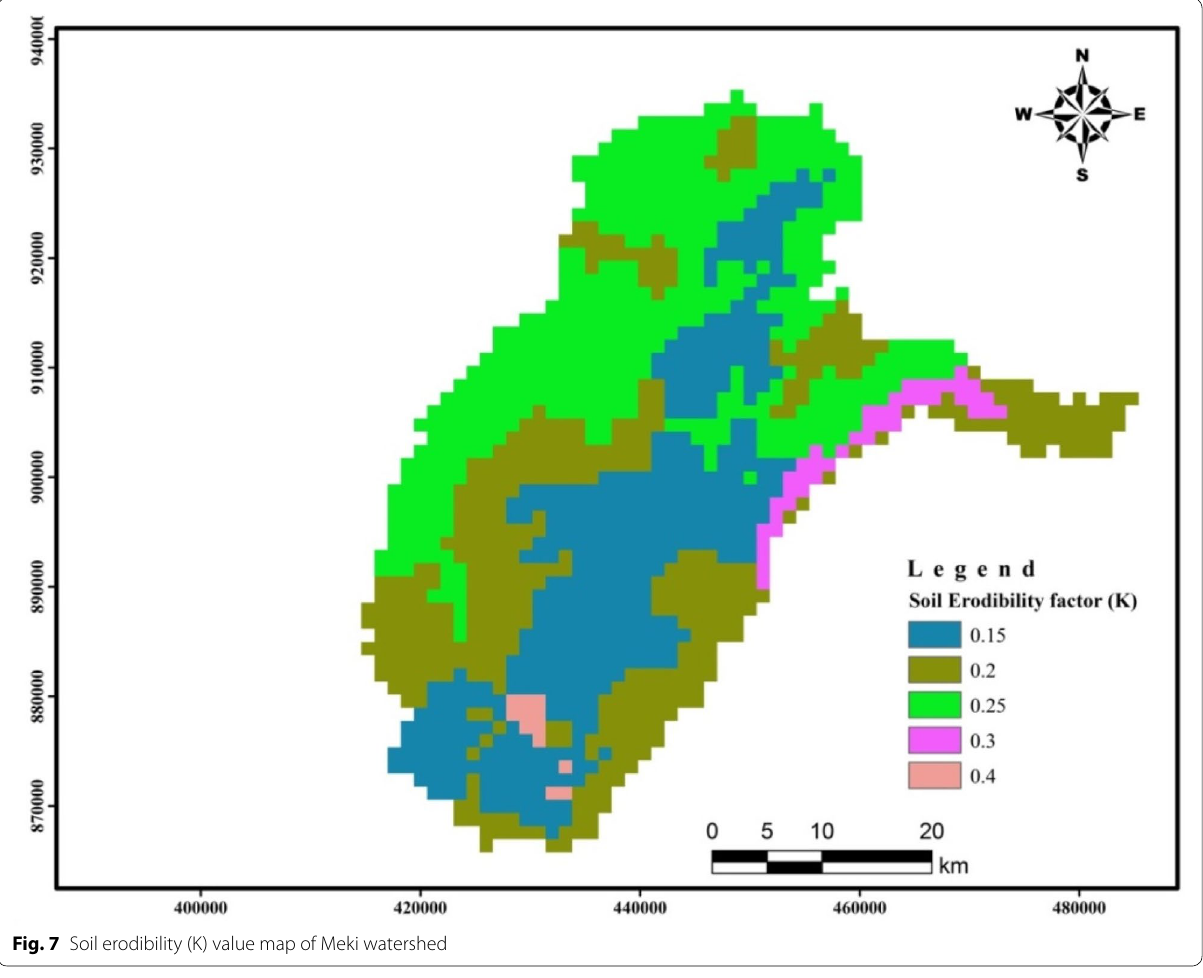
Fig. 7 Soil erodibility (K) value map of Meki